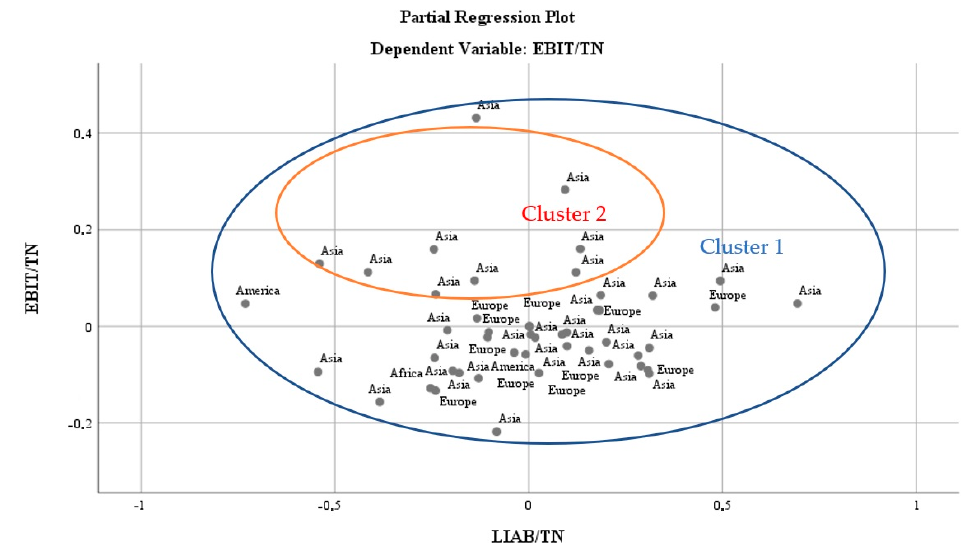
Figure 6. Distribution clusters of the value of the regressor return on the use of borrowed capital on the overall economic performance rate.